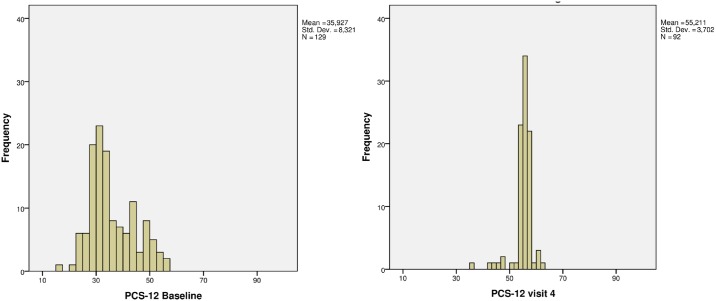
Histograms of PCS-12 at baseline and after six-month treatment.